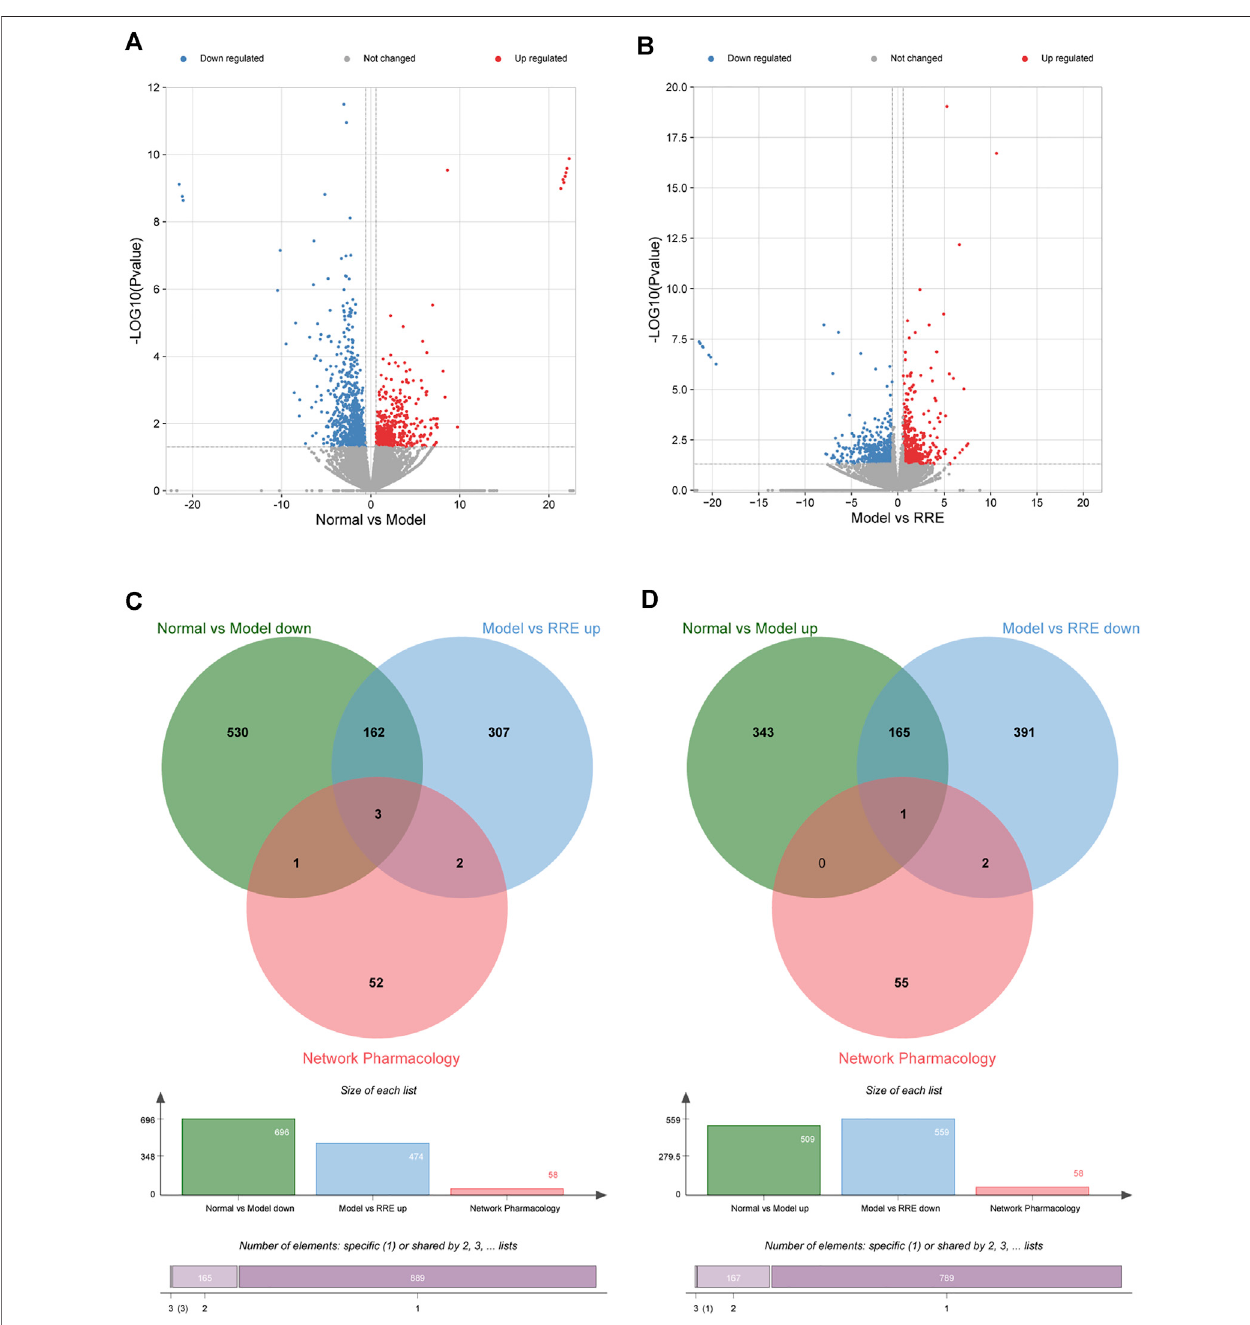
FIGURE 3 | Potential antidiabetic targets of RR were predicted by transcriptome analysis. (A) Volcano map shows the number of DEGs in the normal vs . model group; (B) VolcanomapshowsthenumberofDEGsinthemodel vs .RREgroup.Theabscissarepresentsthefoldchangeofthegene,andtheordinaterepresentsthe p value. Each dot in the fi gure represents a speci fi c gene, the red and blue dots represent signi fi cantly upregulated and downregulated genes, respectively, while the gray dotsrepresentnonsigni fi cantlydifferentgenes.Screeningcriteriaare|FC| > 1.5and p < 0.05. (C,D) Venndiagrams:thecirclesindifferentcolorsintheVenndiagram represent a DEGs set and the intersection of the circles represents the number of DEGs shared between each set. (C) Intersection of DEGs from the normal vs . model group (down) and the model vs . RRE group (up) by transcriptomics and network pharmacology analysis. (D) Intersection of DEGs from the normal vs . model group (up) and the model vs . RRE group (down) by transcriptomics and network pharmacology